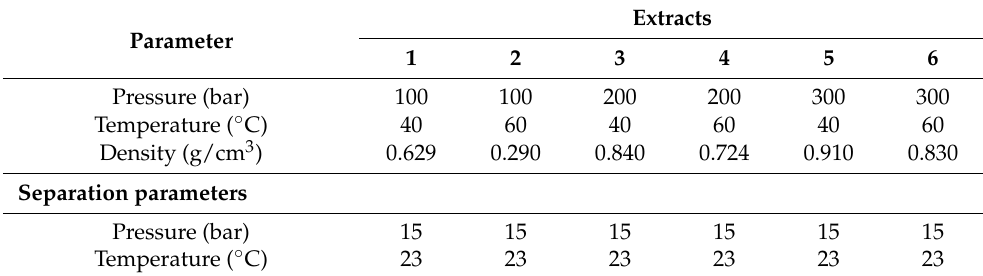
Table 1. Supercritical fluid extraction and separation conditions (data originated from